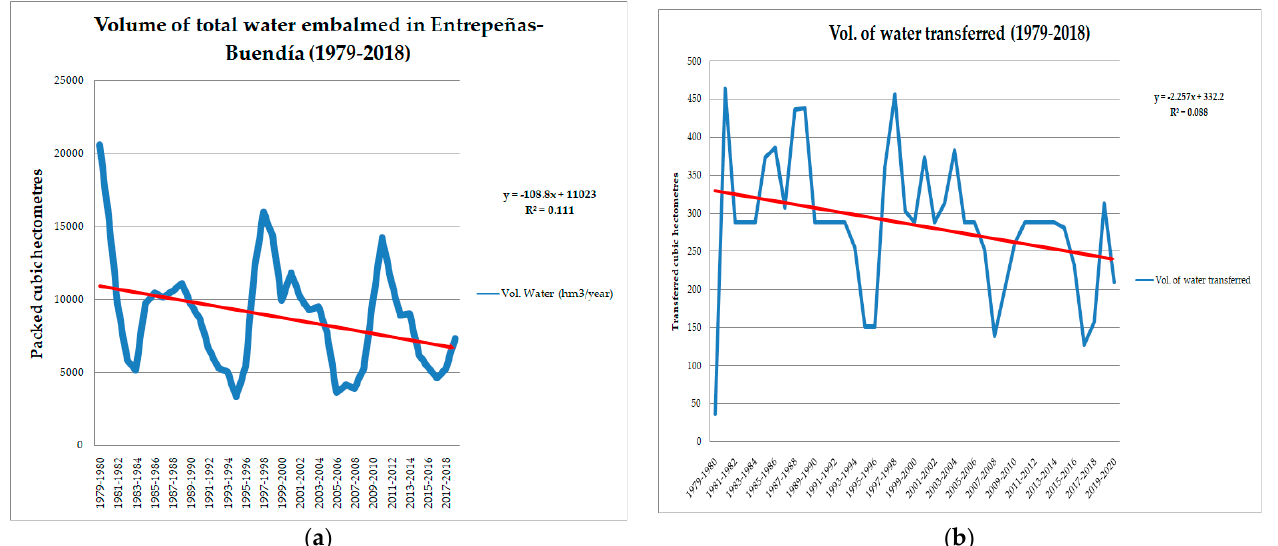
Figure 4. Graph comparison between water stored in the Entrepeñas–Buendía reservoir and volumes of water transferred by the Tagus–Segura aqueduct. ( a ) Evolution of water reservoirs in the Entrepeñas–Buendía reservoir (1979–2018); ( b ) evolution of volumes of water transferred by the Tagus–Segura aqueduct (1979–2018). Source: yearbooks of gauges in Spain. Own elaboration.